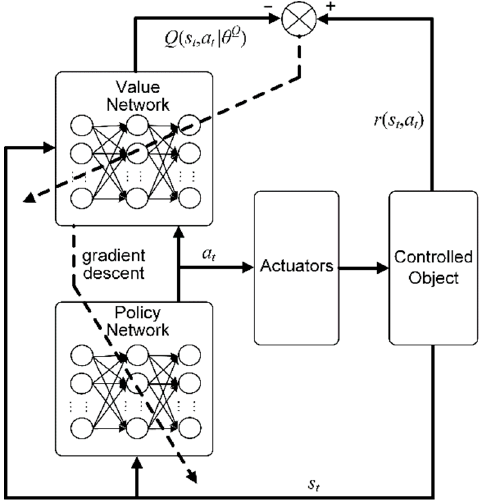
Figure 2. Schematic diagram of on-line reinforcement learning control method.